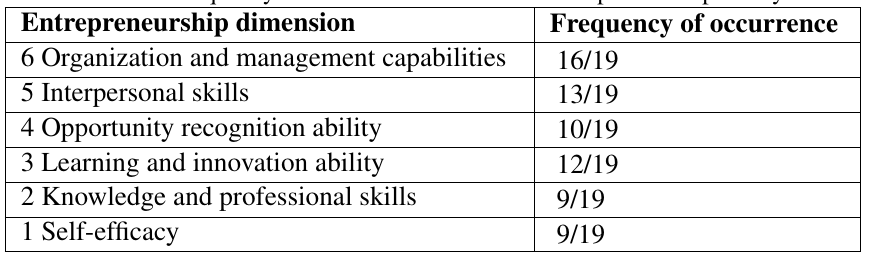
Table 1 Frequency statistics of dimensions of entrepreneurship